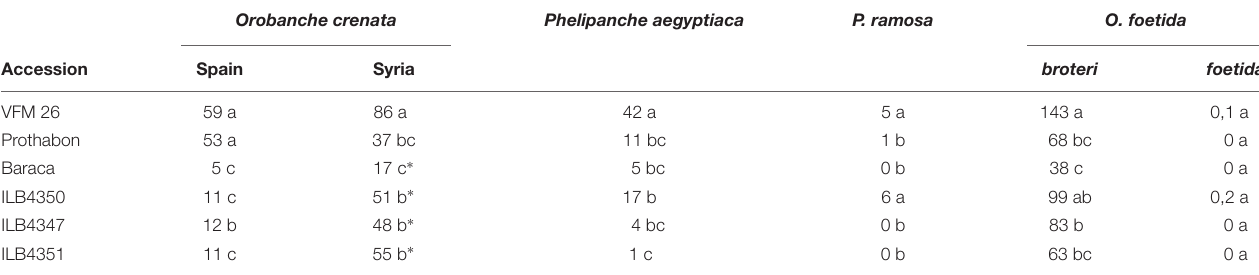
TABLE 1 | Total number of broomrapes per plant formed on roots of faba bean accessions.